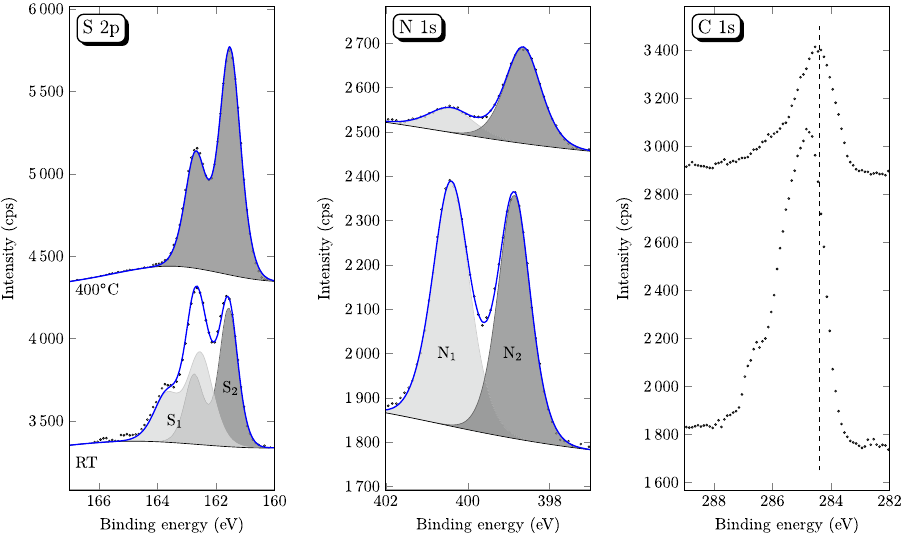
Fig. 9 High resolution XPS spectra obtained on the metallic Cu(111) with pre-adsorbed 2-MBI layer at saturation before and after annealing at 400 ∘ C during 10 min. The S 2p, N 1s and C 1s core